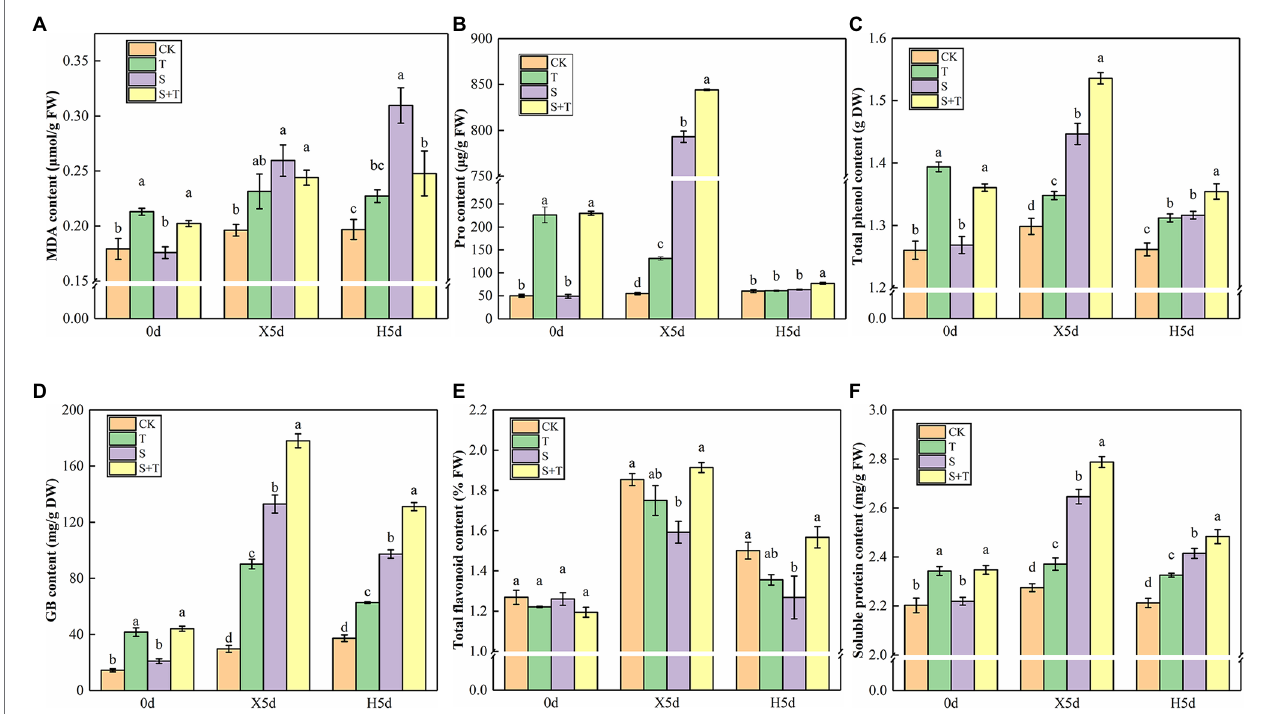
FIGURE 5 | Impact of exogenously applied trehalose on osmotic substances of tomato leaves under stress and non-stress conditions. (A) MDA content. (B) Pro content. (C) Total phenol content. (D) GB content. (E) Total flavonoid content. (F) Soluble protein content. The results showed the mean ± SE of three replicates, and the different letters denote the significant difference among treatments ( p < 0.05), according to Duncan’s multiple test. CK, control; T, 10 mM trehalose; S, 150 mM NaCl; S + T, 150 mM NaCl +10 mM trehalose.